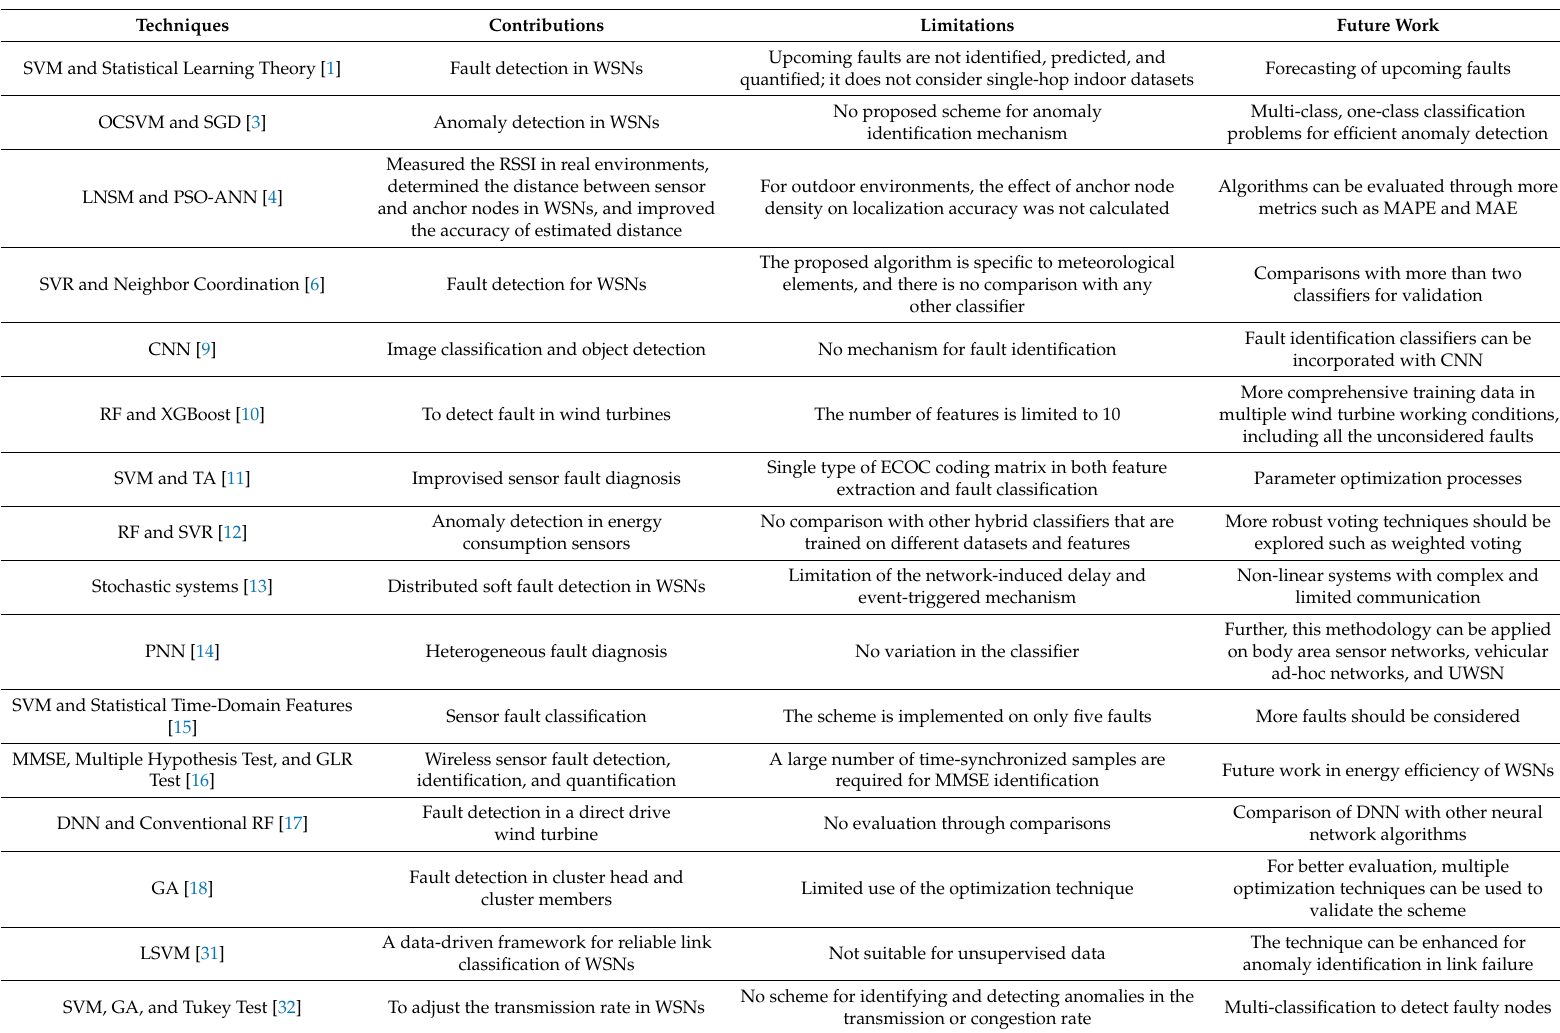
Table 2. Summary of related